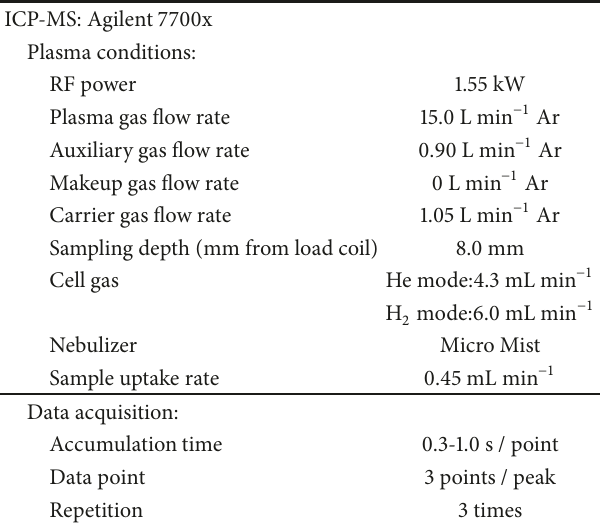
Table 1: Operating conditions for the ICP-MS